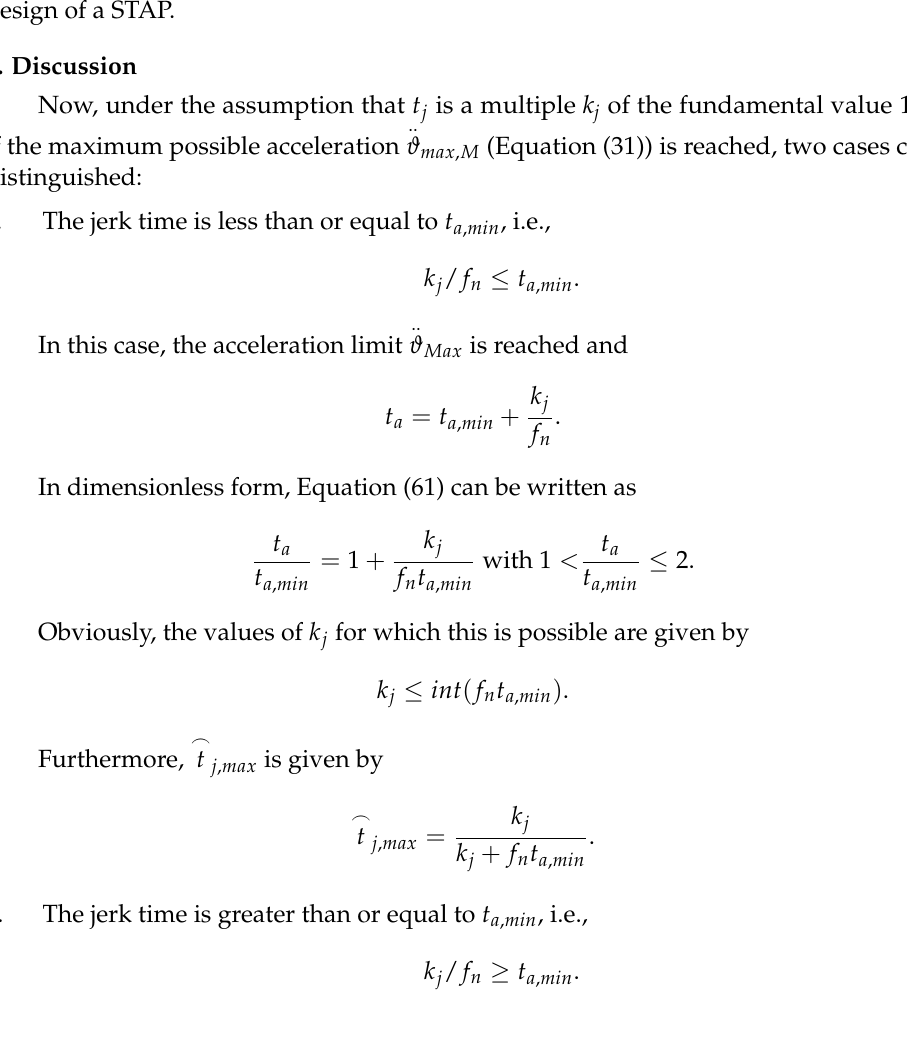
Figure 23. Motor torque versus time: ( a ) J L / J M = 1.00; ( b ) J L / J M = 0.25.